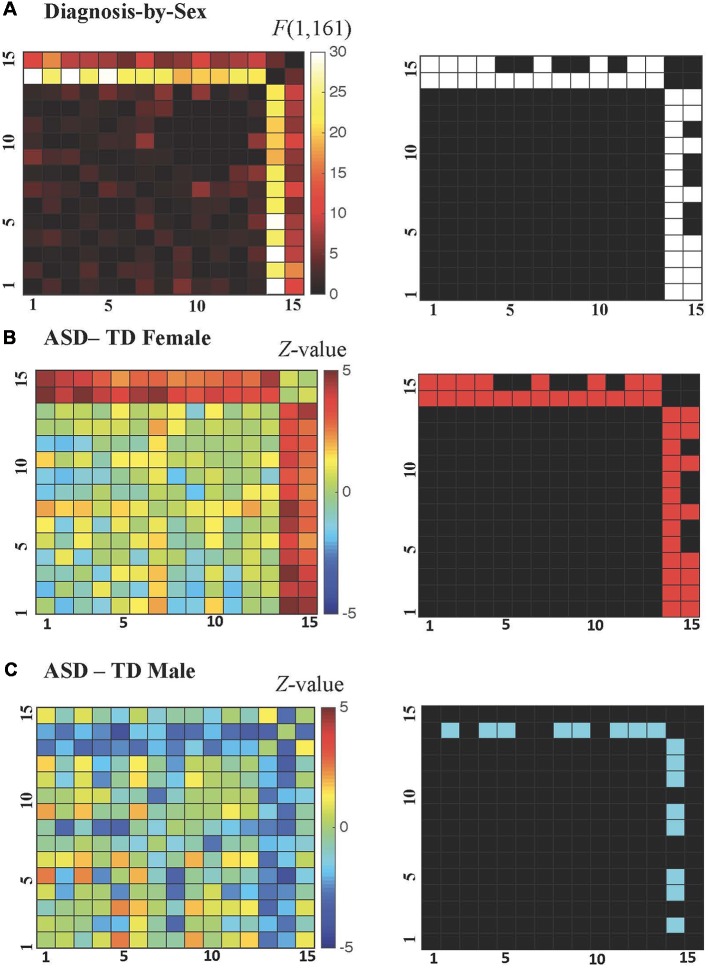
(A–C) Cerebellar-cortical region correlation matrices. (A)
F-values for diagnosis-by-sex interaction (left), and surviving pairs at P < 0.0069 after false discovery rate (FDR) correction to q < 0.05 shown in white (right). (B) Z-values for ASD—TD contrast in females (left), and surviving pairs at P < 0.0216 (FDR-corrected to q < 0.05 within those combinations already FDR-corrected in the diagnosis-by-sex contrast) shown in red (right). (C) Z-values for ASD—TD contrast in males (left), and surviving pairs at P < 0.0216 (FDR-corrected to q < 0.05 within those combinations already FDR-corrected in the diagnosis-by-sex contrast) shown in blue (right).